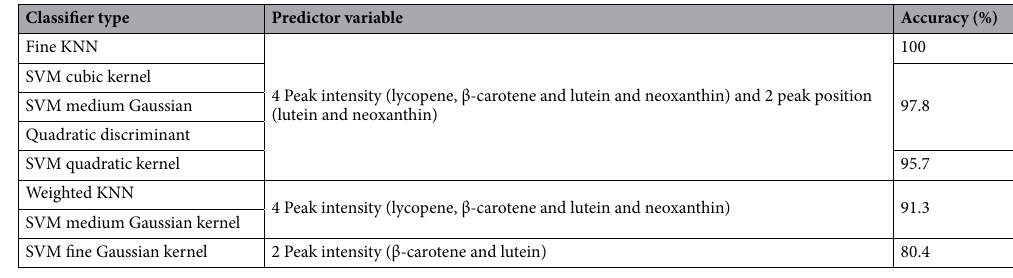
Table 2. Summary of classification analysis